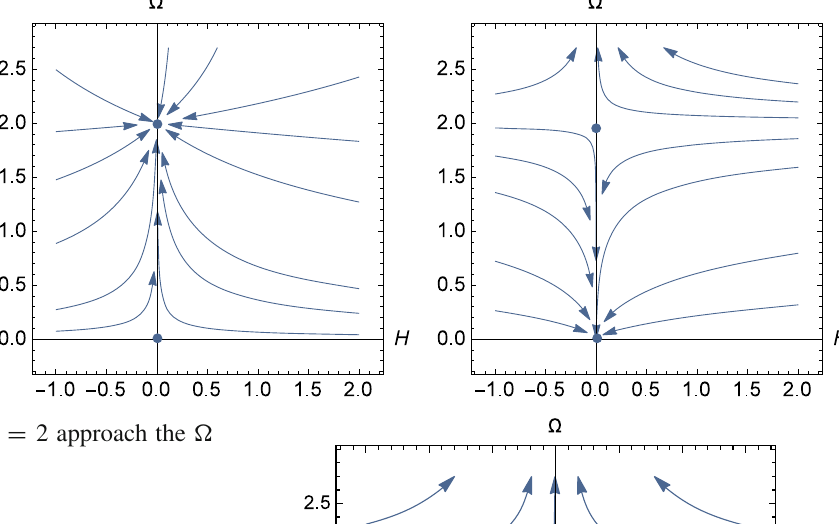
trajectories starting above the line (cid:4) 0 = 2 approach the (cid:4)